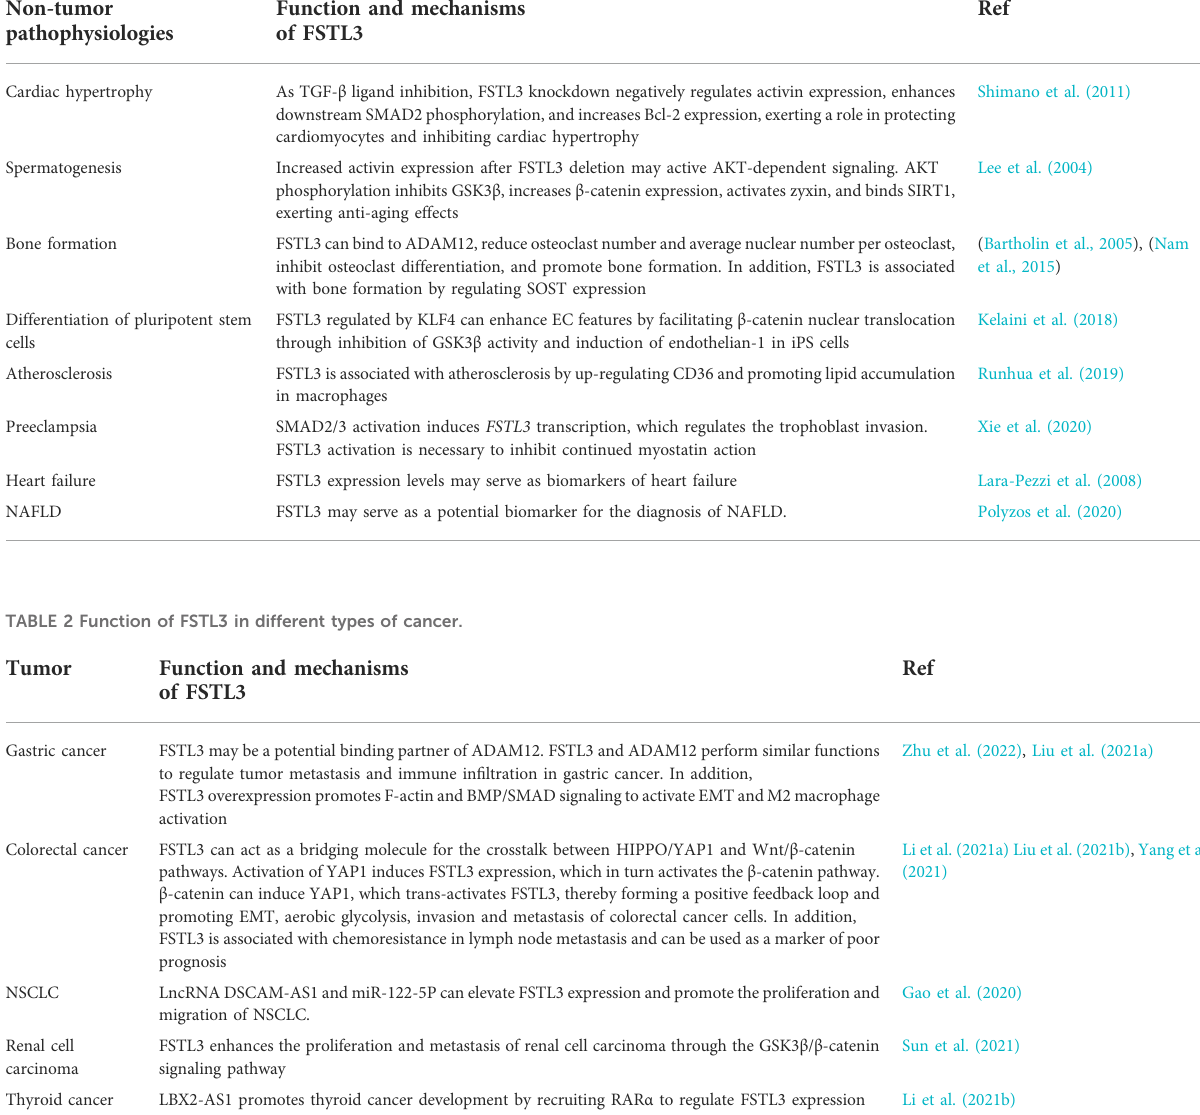
TABLE 1 FSTL3 in non-tumor pathophysiologies. Non-tumor pathophysiologies